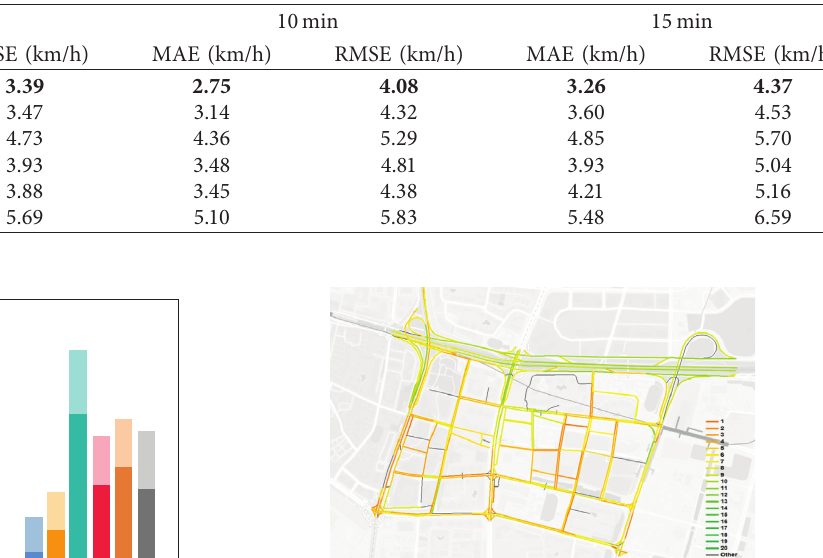
Table 6: Average prediction error of each algorithm.